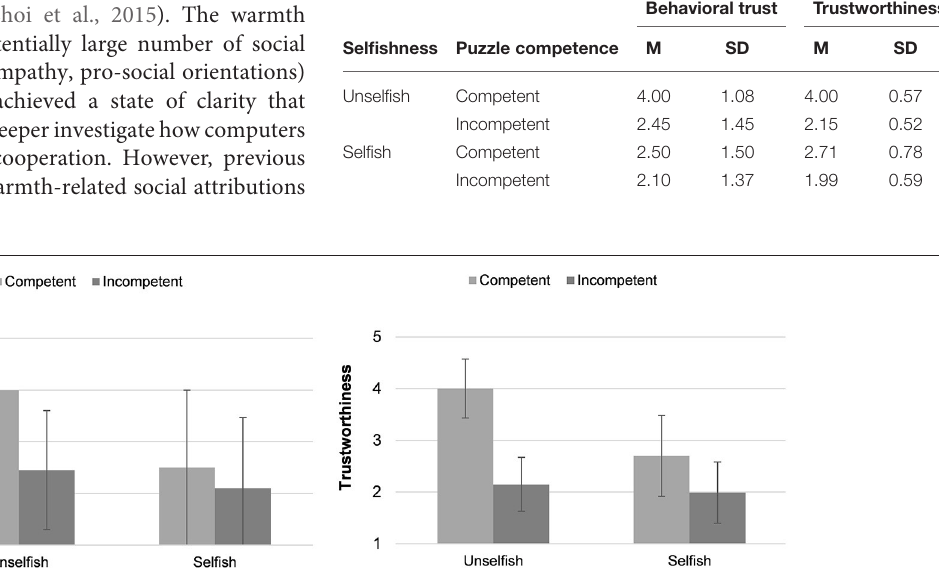
Frontiers in Digital Humanities |